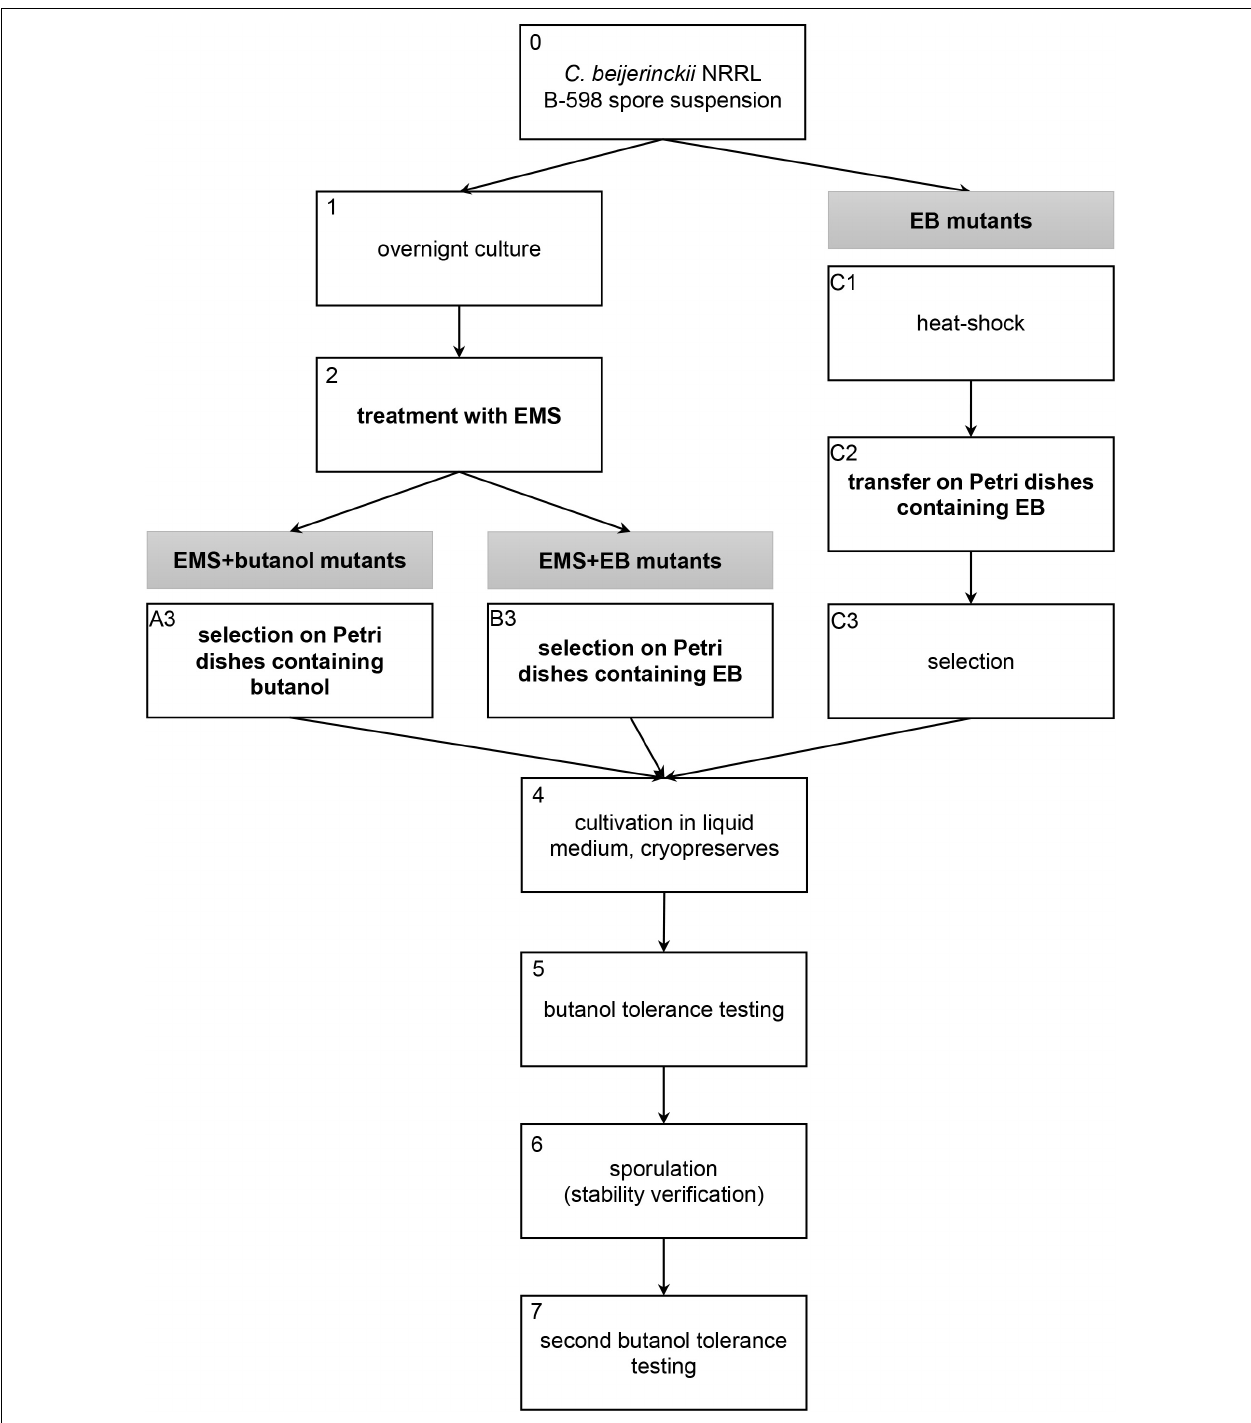
FIGURE 1 | Scheme of three random chemical mutagenesis approaches that were used to obtain mutant strains of C. beijerinckii NRRL B-598 with increased butanol tolerance. EMS, ethyl methanesulfonate; EB, ethidium bromide.